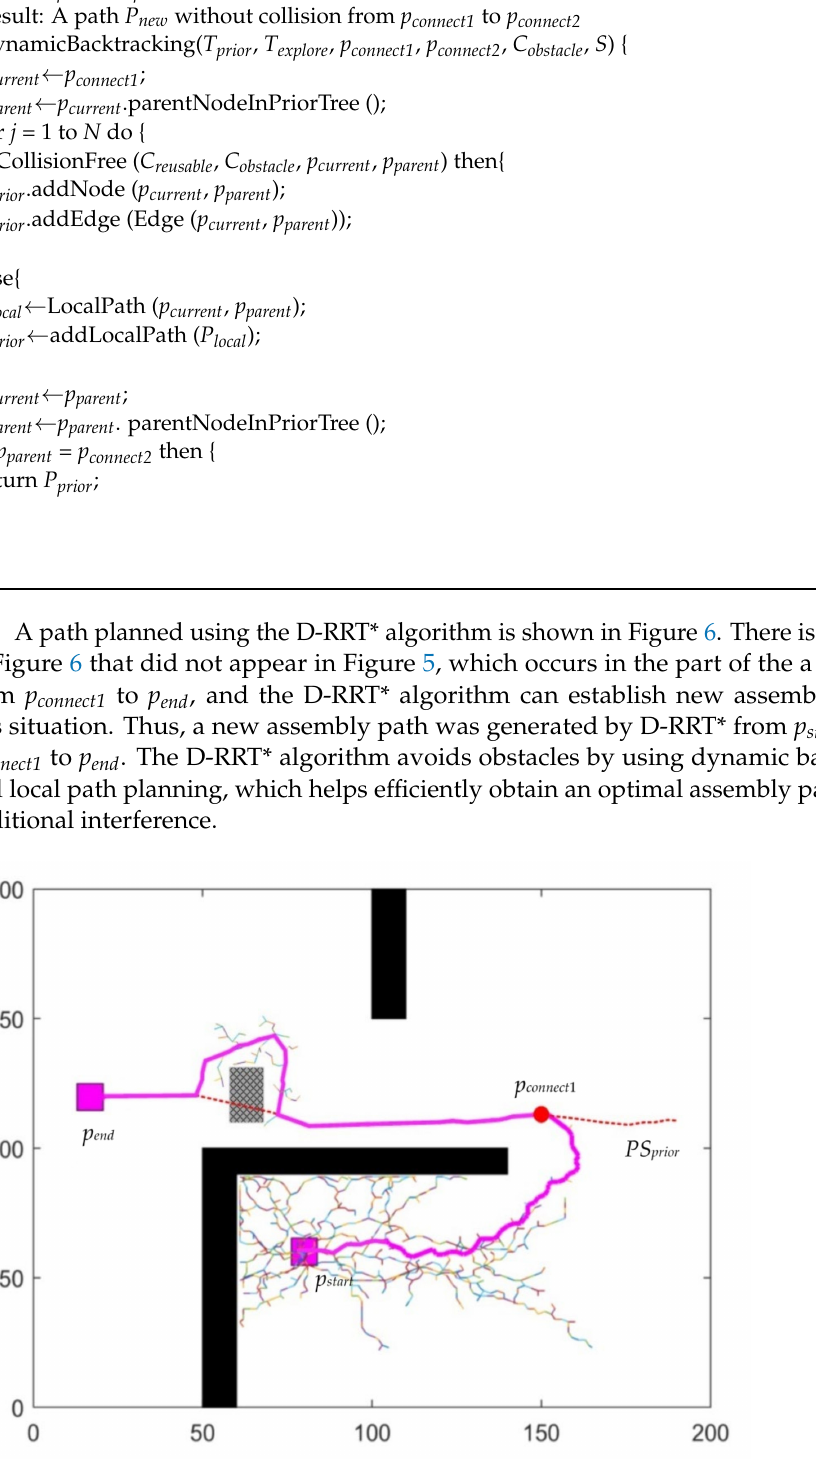
Figure 6. A path planned using dynamic RRT* (D-RRT*) for dynamic reuse of the a priori